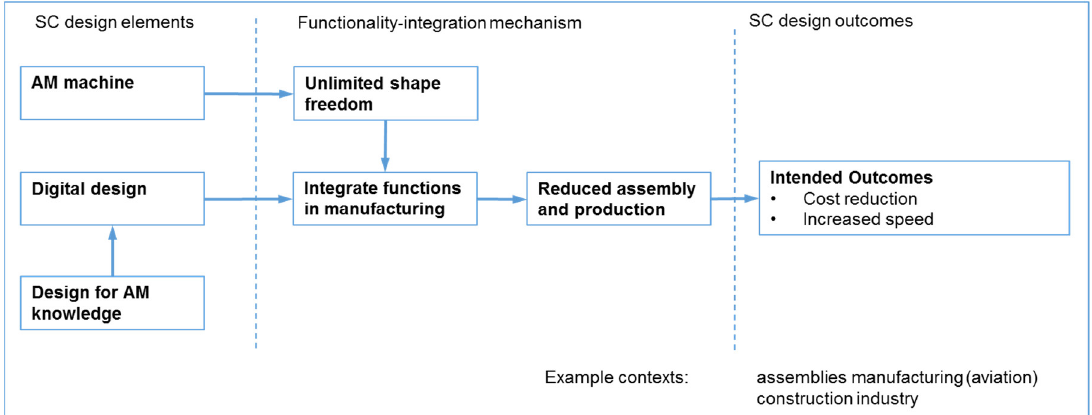
Figure 7. Functionality-integration mechanism.